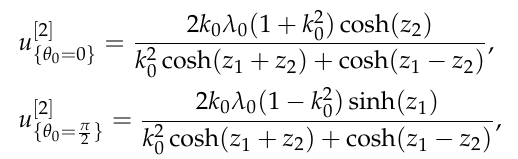
[ 2 ] ( left ), and u { θ 0 = 0 }